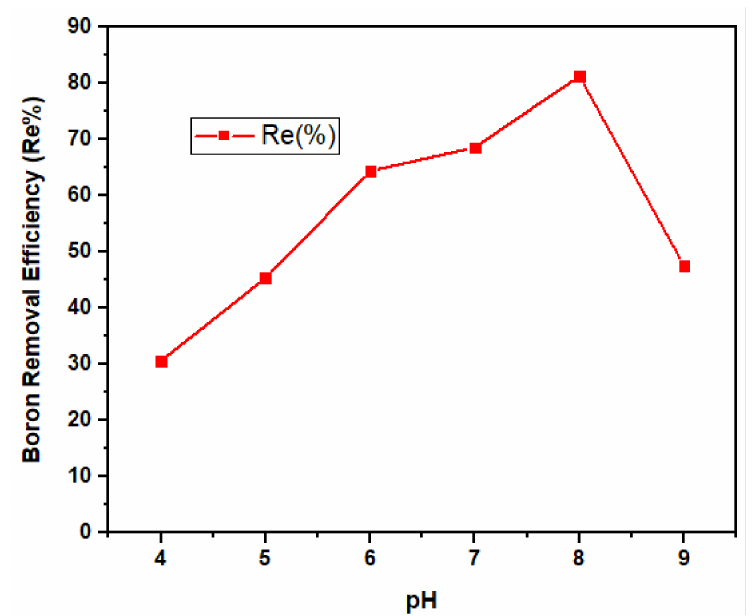
Figure 11. Boron removal efficiency by nano-magnetite under variable pH (4–9) at fixed dose (0.5 g) and contact time (180